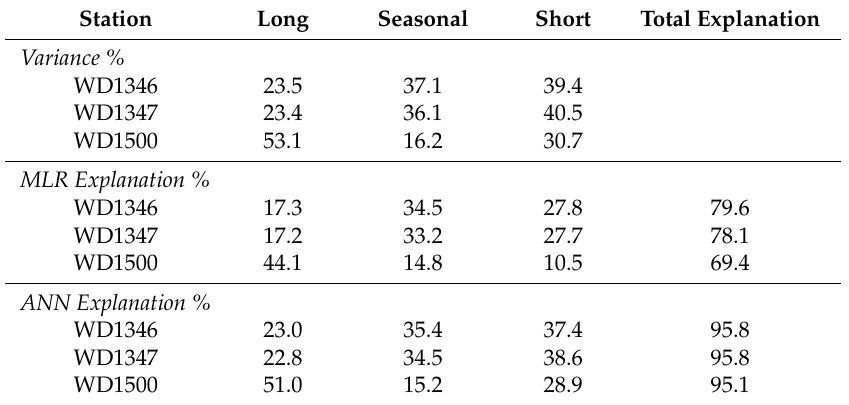
Table 4. Summary of the explanation in the water discharge time series for all the